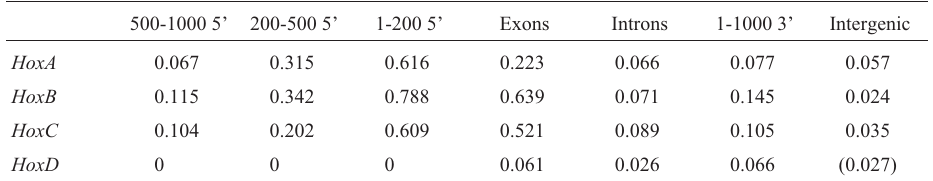
Table 3 - Fractions of the total number of alignment columns in each distinct genomic domain contained in the regions of minimal length 25 bp, with av- erage conservation rate of 0.1 or better. The intergenic data for HoxD have been parenthesized because of the Ensembl gene prediction at the location where many of these regions were